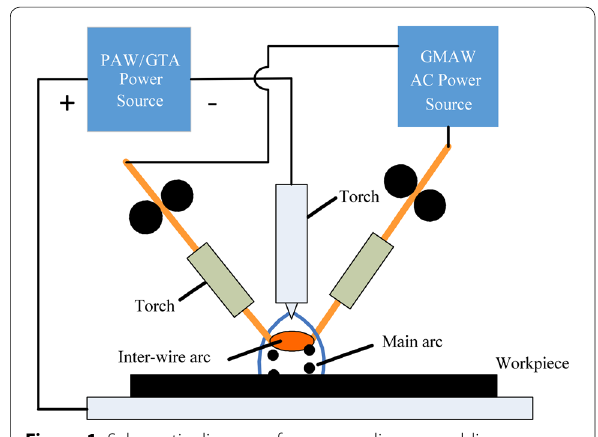
Figure 1 Schematic diagram of cross-coupling arc